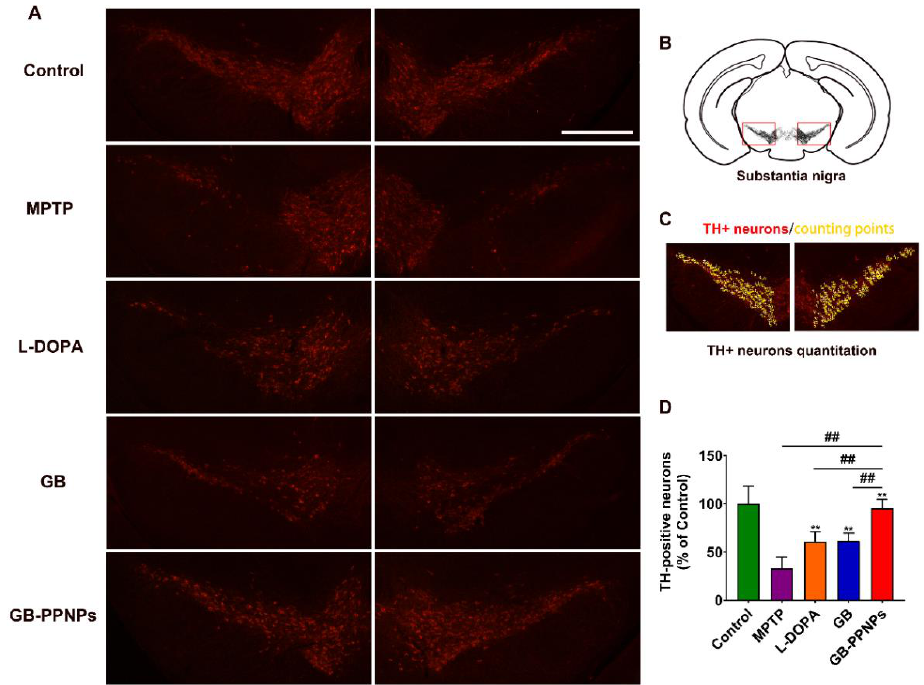
Figure 7. The in vivo neuroprotection of GB-PPNPs in MPTP-treated PD model mice. ( A ) Representative TH-stained murine brain sections. ( B ) Schematic illustration of the representative brain sections. Scale bar: 500 μm. ( C ) Quantification of TH + neurons by manual counting with ImageJ software. ( D ) The number of TH + neurons (both the right and the left substantia nigra) in the indicated treatments ( n = 6). ** p < 0.01 with respect to MPTP. ## p < 0.01 with respect to GB-PPNPs.